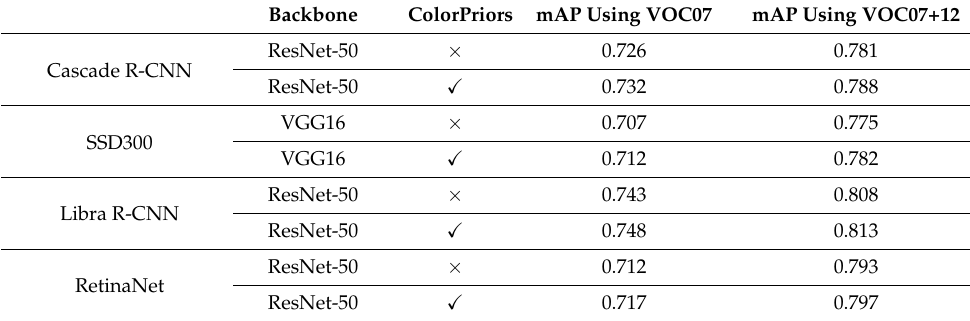
Table 6. Comparative experiments of different target detection